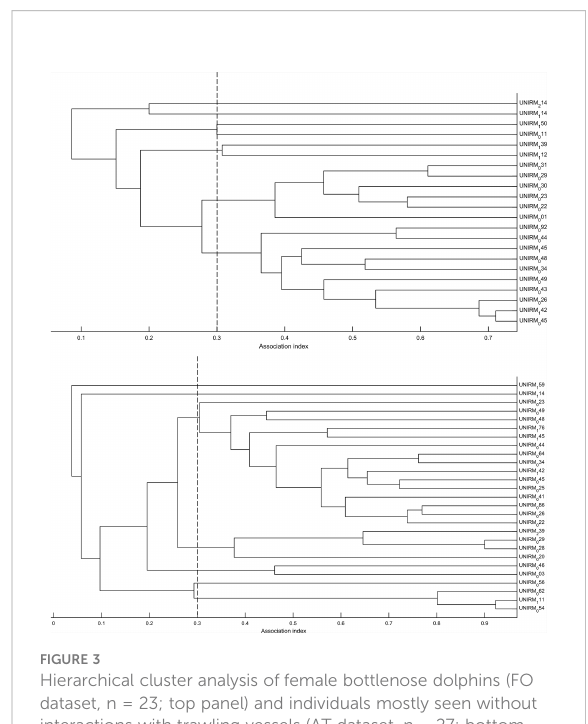
FIGURE 3 Hierarchical cluster analysis of female bottlenose dolphins (FO dataset, n = 23; top panel) and individuals mostly seen without interactions with trawling vessels (AT dataset, n = 27; bottom panel) using the half-weight